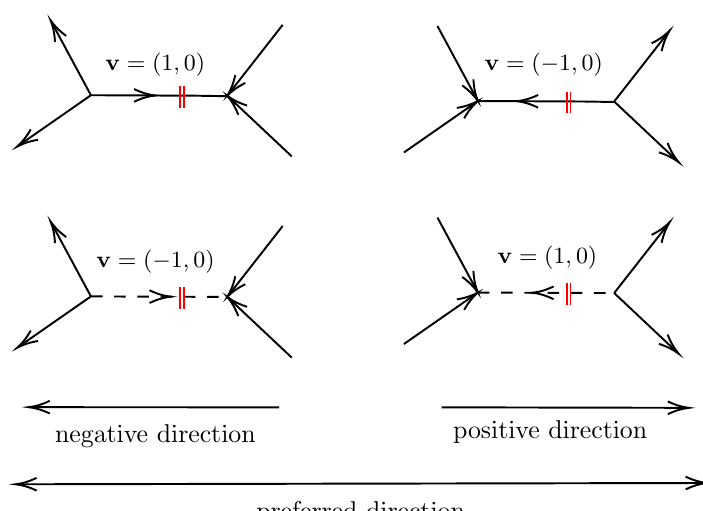
Figure 6 . Positive and negative direction of the preferred direction. When the edge parallel to the preferred direction is a solid line and points at the positive direction, we assign vector v = (1 , 0) , when it is a solid line and points at the negative direction, we assign vector v = ( − 1 , 0) . Oppositely, when the preferred edge is a dashed line and points at the positive direction, we assign vector v = ( − 1 , 0) , when it is a dashed line and points at the negative direction, we assign vector v = (1 , 0)